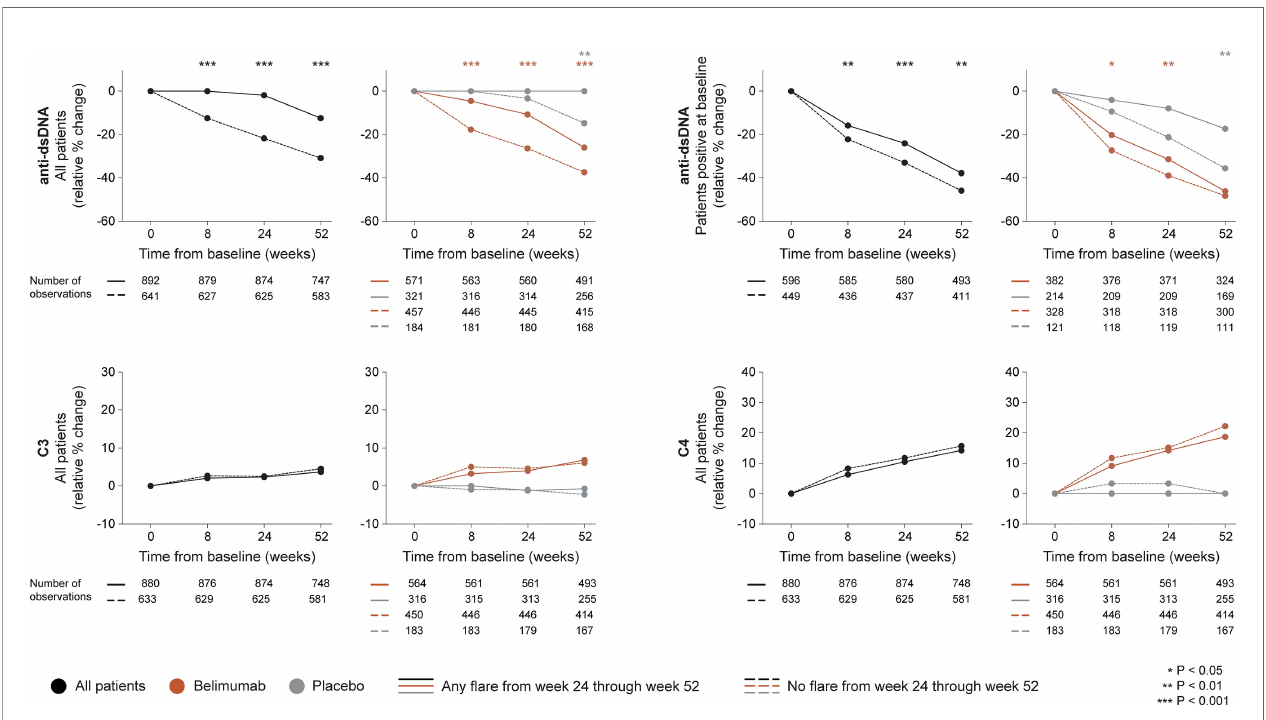
FIGURE 2 | Changes in serological markers in relation to fl ares occurring from week 24 through week 52. The graphs delineate relative to baseline percentage changes in anti-dsDNA, C3 and C4 levels from baseline through different time points in patients who developed at least one SFI fl are (mild/moderate or severe) from week 24 through week 52 (continuous lines) and patients who did not (dashed lines). Comparisons between patients who fl ared and patients who did not were conducted for the entire population with available data (black lines), and after strati fi cation into patients who received standard therapy plus belimumab (terracotta lines) and patients who received standard therapy alone (grey lines). For anti-dsDNA levels, a separate analysis for patients with positive anti-dsDNA levels ( ≥ 30 IU/ mL) at baseline is also demonstrated. P values derived from non-parametric Mann-Whitney U tests. The number of patients with available data at each time point is indicated for each patient subgroup. SFI, Safety of Estrogens in Lupus Erythematosus National Assessment (SELENA) - Systemic Lupus Erythematosus Disease Activity Index (SLEDAI) Flare Index; anti-dsDNA, anti-double stranded DNA antibodies; C3, complement component 3; C4, complement component